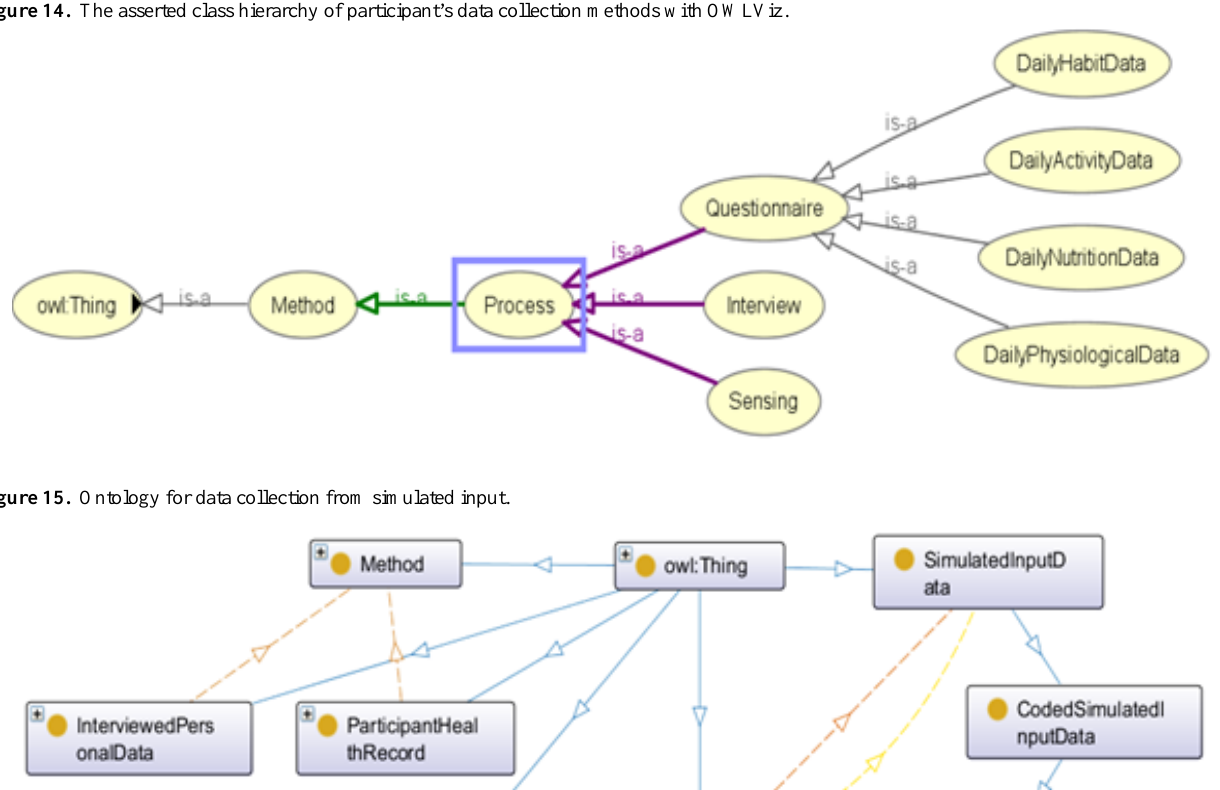
Figure 14. The asserted class hierarchy of participant’s data collection methods with OWLViz.